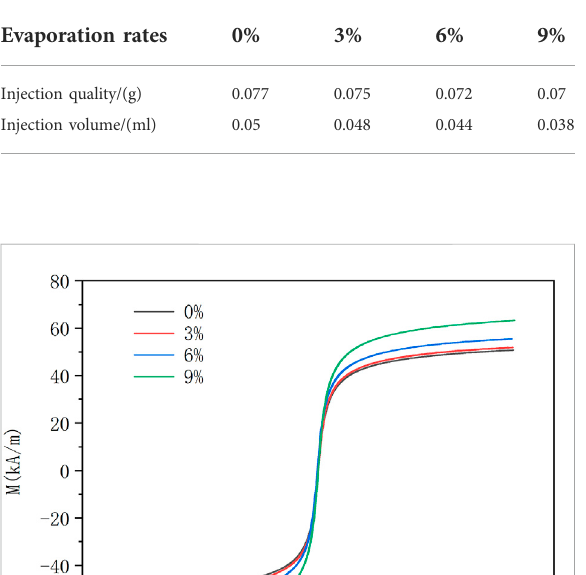
TABLE 2 Different evaporation rate magnetic fl uid density and saturation magnetization